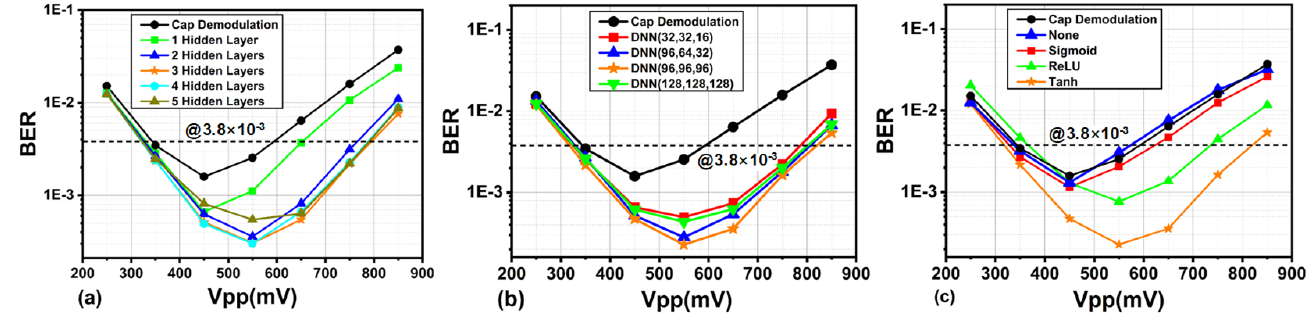
Figure 4. The relationship between BER performance and ( a ) the number of hidden layers; ( b ) nodes of each hidden layer; ( c ) the activation functions of traditional DNN converter under different signal Vpp.